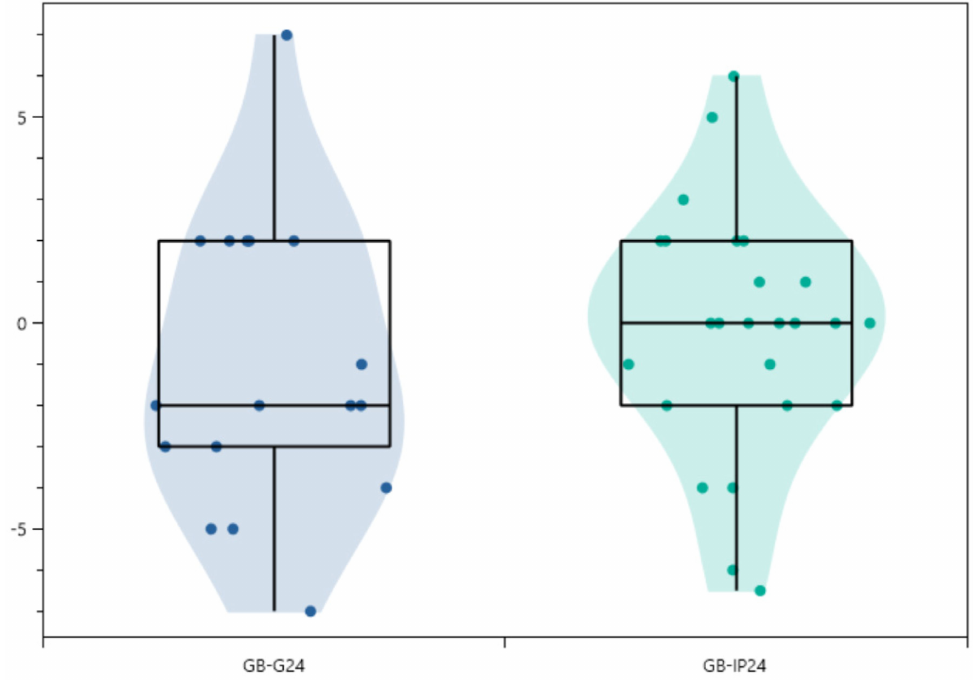
Figure 3. Box plots of loss of correction in the granule group (GB-G24) and the putty group (GB-IP24) groups, 24 months follow-up. There were no outliers. More than 50% of the data are included in the box plot for each material. The median is 0 for the putty group and − 2 for the granule group. The results reflect little or no loss of